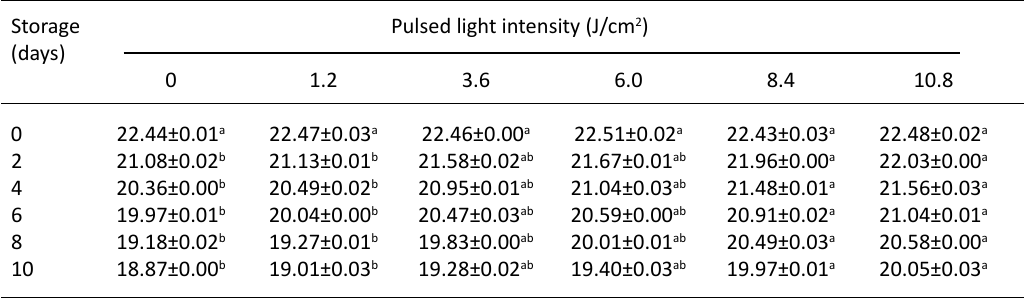
table 6. Vitamin C (mg/100 g) of Chinese kale affected by pulsed light intensity (J/cm 2 ) Storage